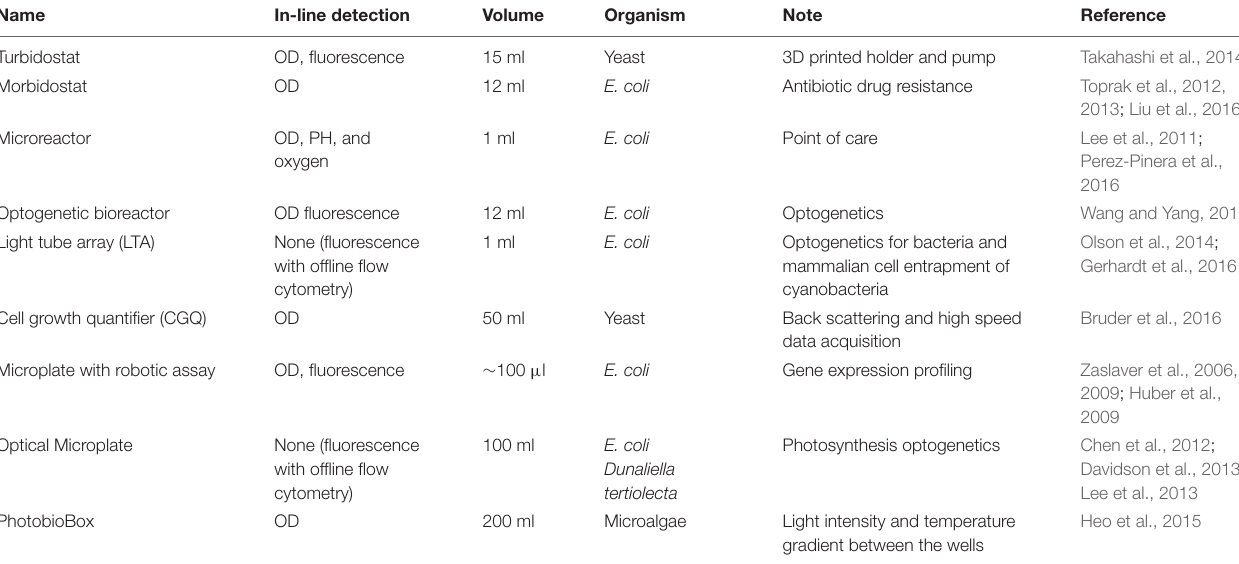
TABLE 1 | Summary of DIY bioreactor and